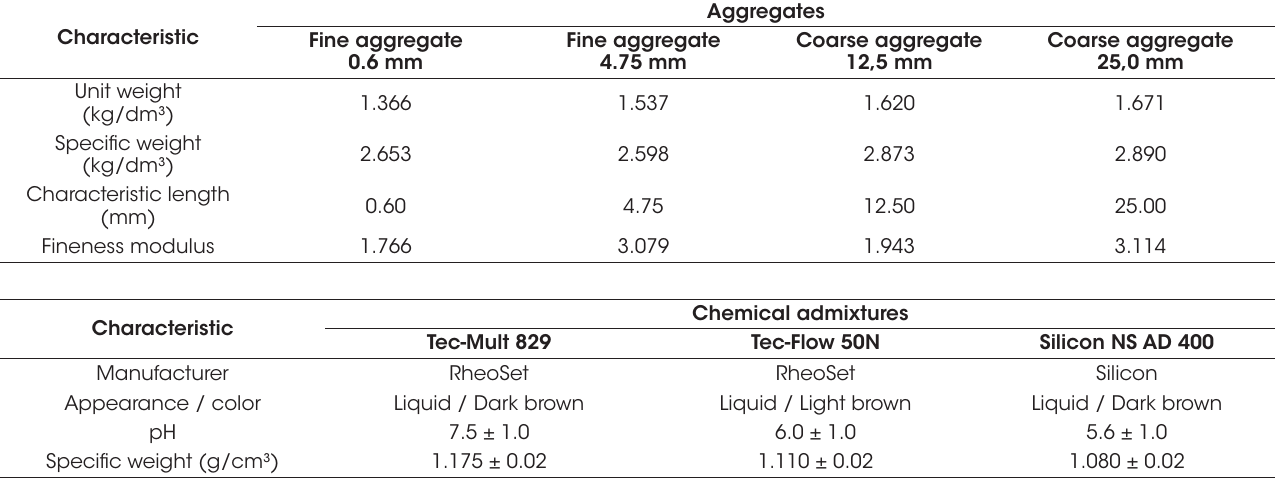
Aggregates characteristics and chemical admixtures